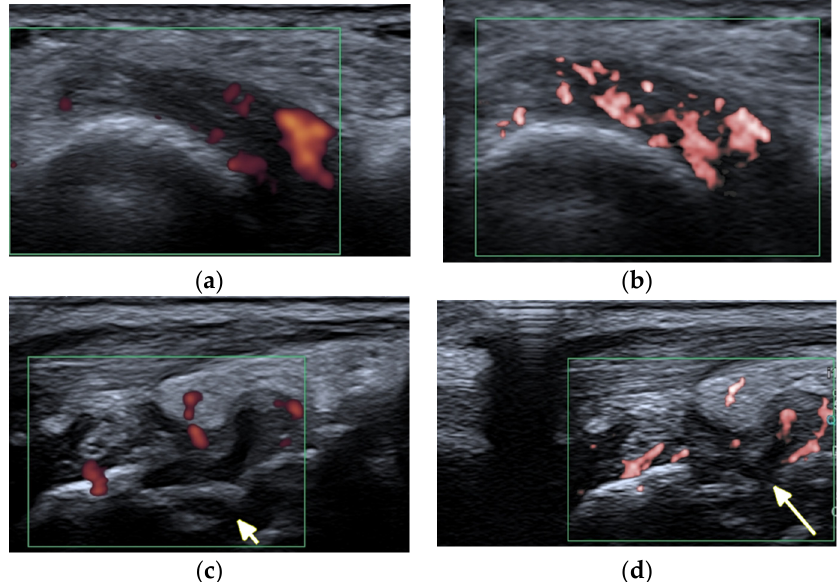
Figure 5. A 57-year-old patient with systemic lupus erythematosus. ( a ) Short-axis power Doppler and ( b ) superb micro-vascular imaging (SMI) ultrasound (US) images of the distal radioulnar joint. ( c ) Long-axis power Doppler and ( d ) SMI US images at the dorsal aspect of the radiocarpal and midcarpal joints show joint effusions and hyperemia consistent with synovitis with more vessels seen with SMI ( b , d ). Note an intra-osseous cyst-like change (short arrow) and cortical erosion (long arrow in ( d )) in the carpal bone related to rhupus syndrome.